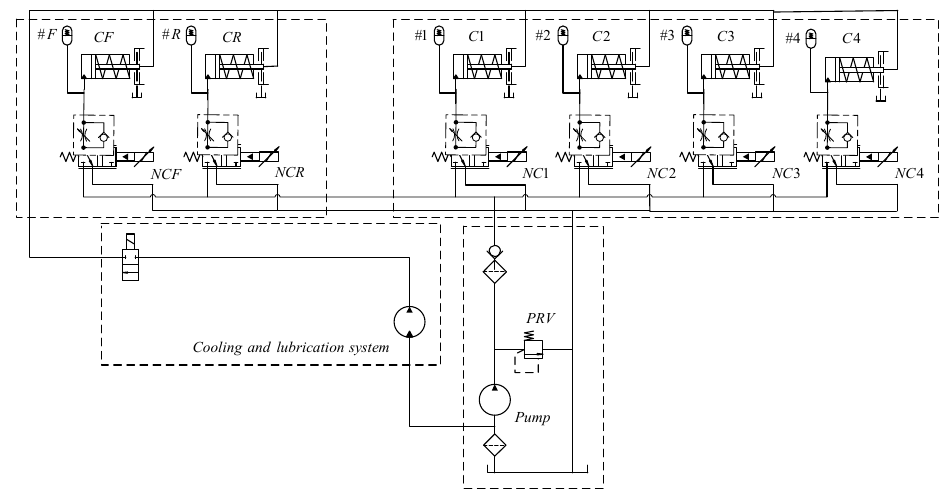
Figure 3. Simplified hydraulic actuation system.